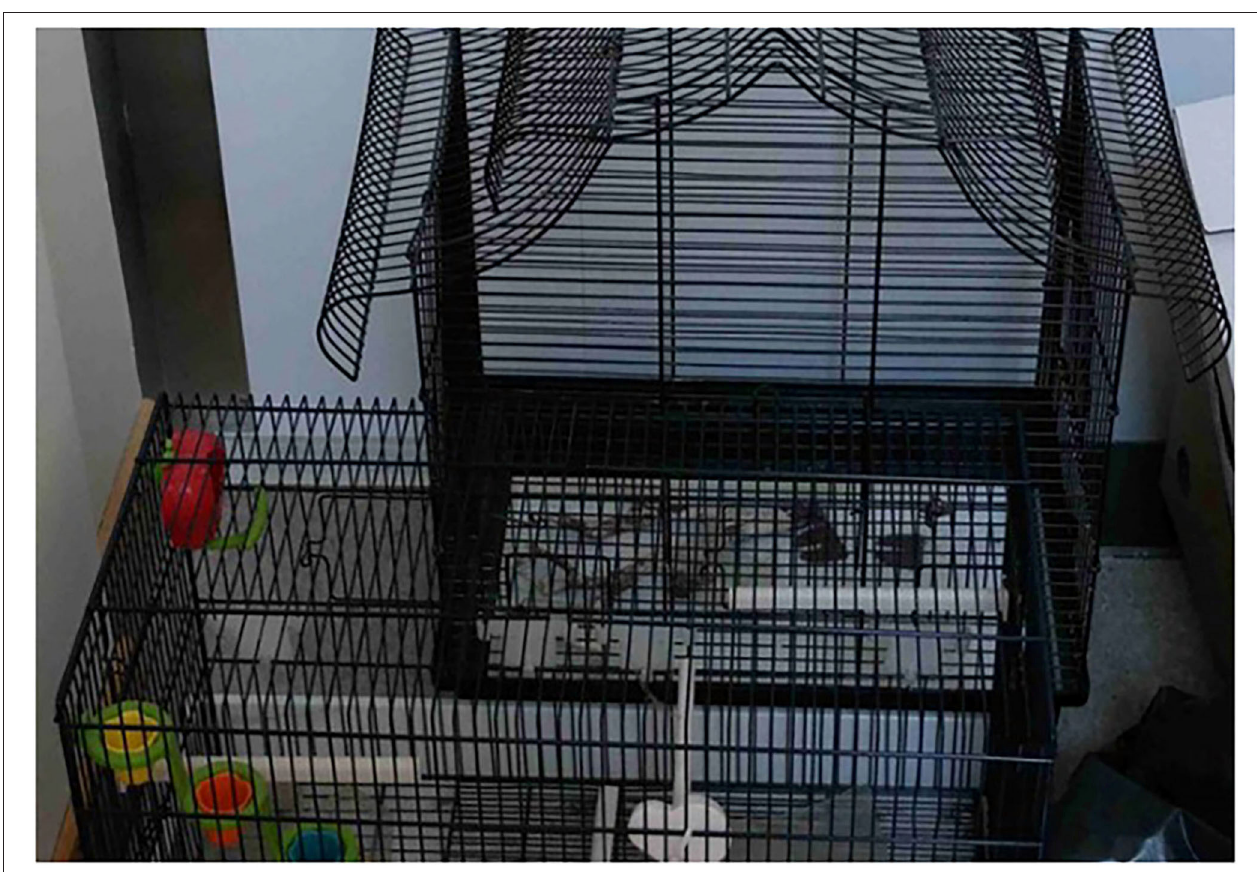
FIGURE 1 | The empty